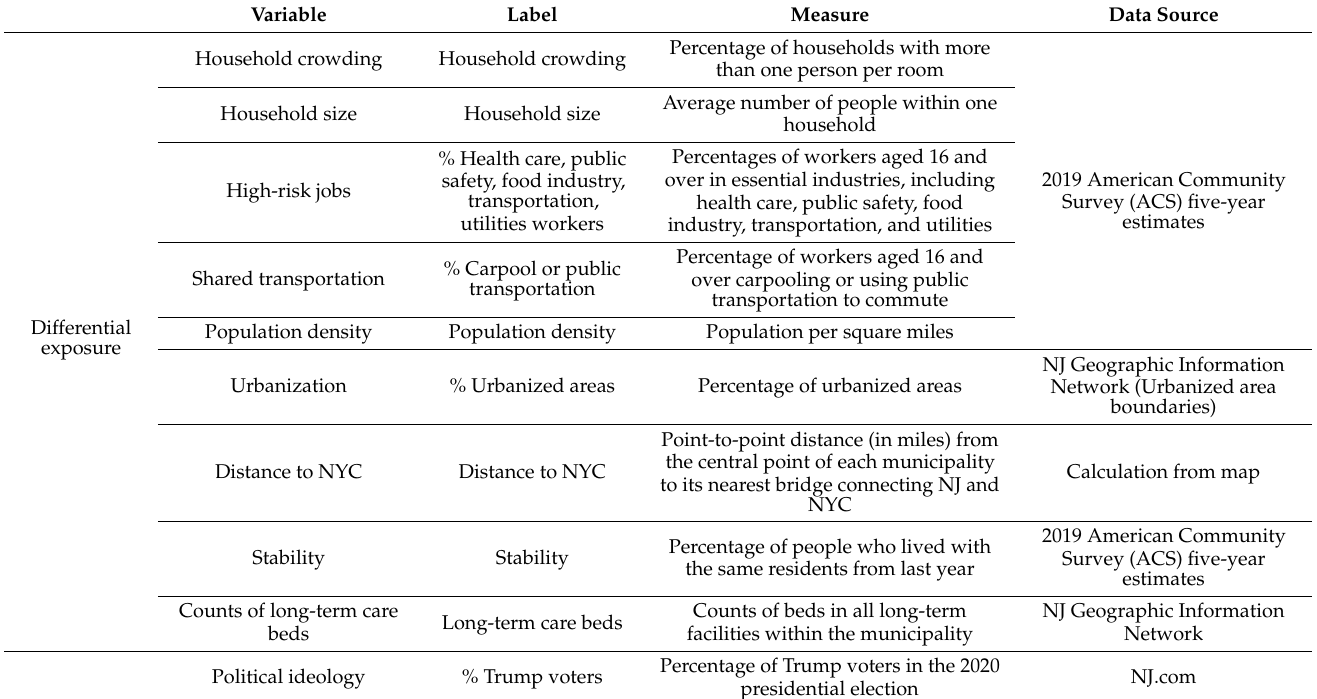
Table A1. List of independent variables with measures and